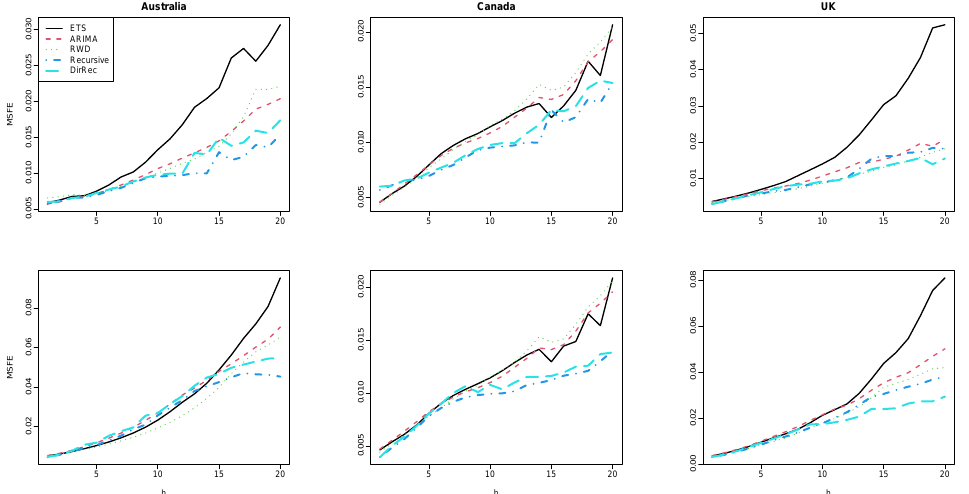
Figure 2. Computed MSFE values of log mortality rates for Australia ( first column ), Canada ( second column ), and UK ( third column ). The results for the female group are given in the first row while the results for the male group are given in the second row.